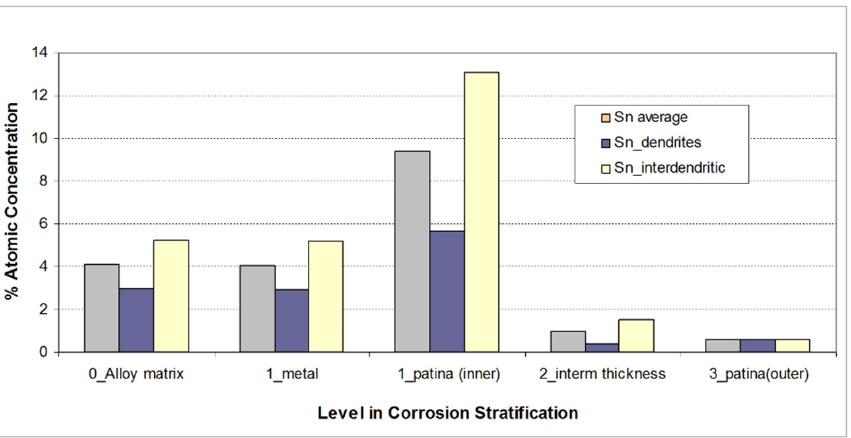
Figure 12. % Sn atomic concentration profile of the corrosion layer stratification in dendritic and interdendritic areas after TB anodic polarization in 0.1 mol/L NaCl—Based on EDS elemental chemical analyses data (fullframe and spot analyses).